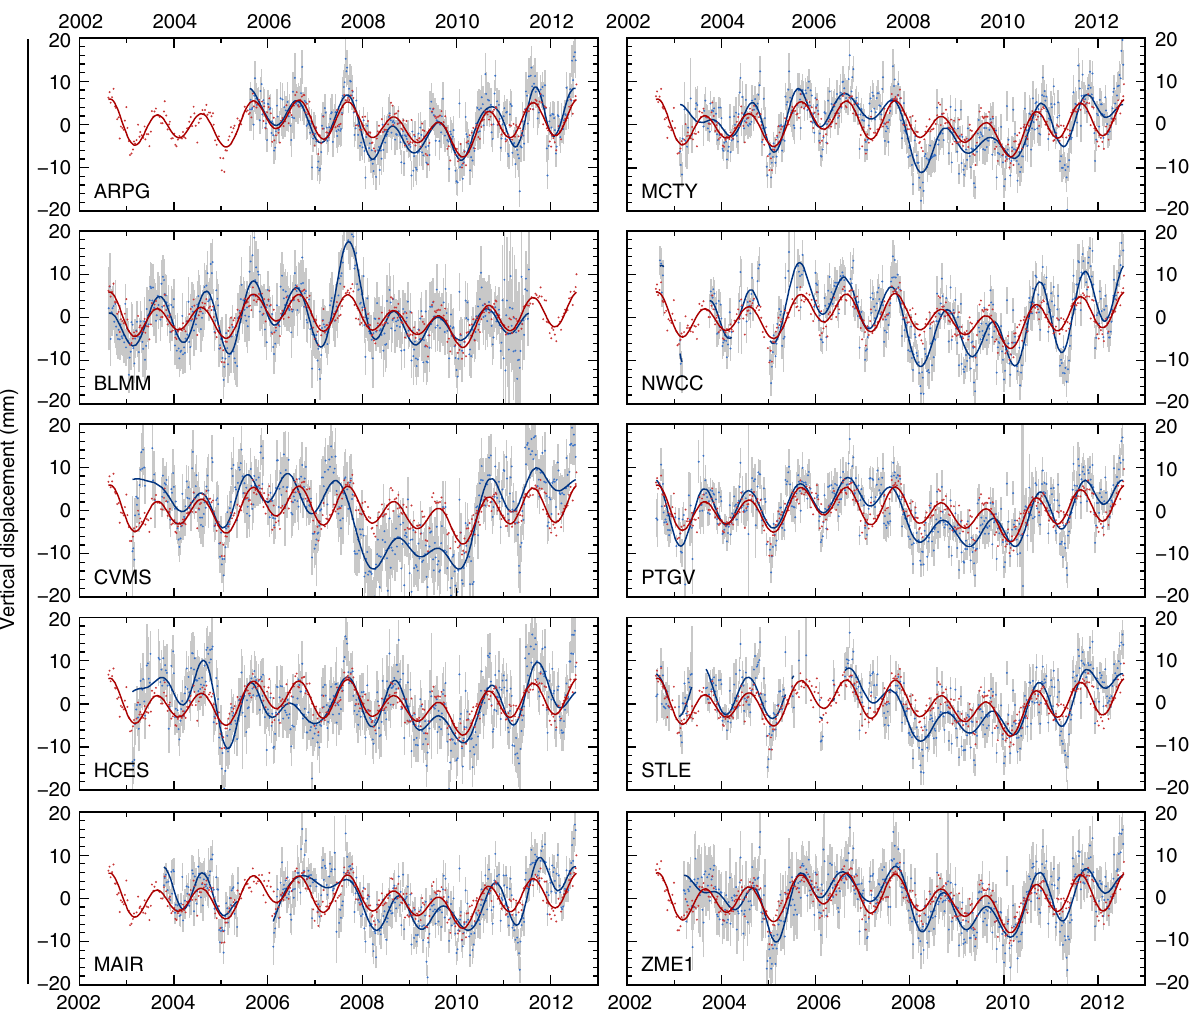
Fig. 5 GPS displacement observations and gravity-derived displacement predictions. Vertical-component GPS displacements for 10 sites with the longest observation periods around the NMSZ (blue points). For processing details, see Methods. Site locations are given in Supplementary Table 1. Time series are corrected for instrumentation-related offsets. Grey bars are 1 σ uncertainties. GPS site locations, identi fi ed by the site ID shown in the lower left of each panel are shown in Fig. 1a. Red points are vertical-component displacements calculated for a layered-elastic spherical Earth response to GRACE-observed surface load variations (see Methods). A best- fi t linear trend has been removed from both GPS and gravity-derived time series. Blue and red lines show a best- fi t 24-component Fourier series to the GPS and gravity time series,